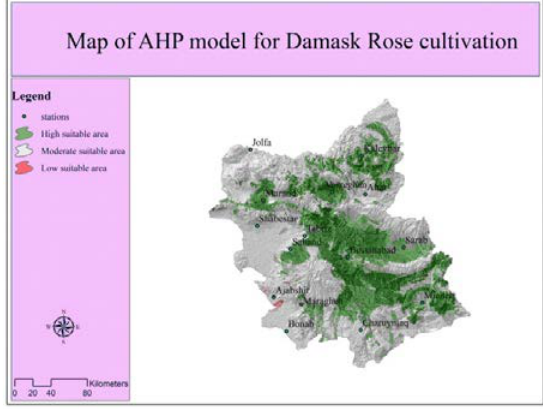
Fig. 5: Suitable areas for cultivation of Damask Rose based on AHP technique Growth degree day